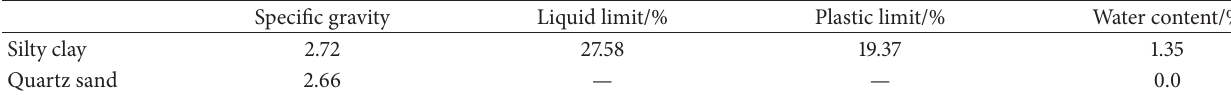
Table 1: The physical parameters of the silty clay and quartz sand.